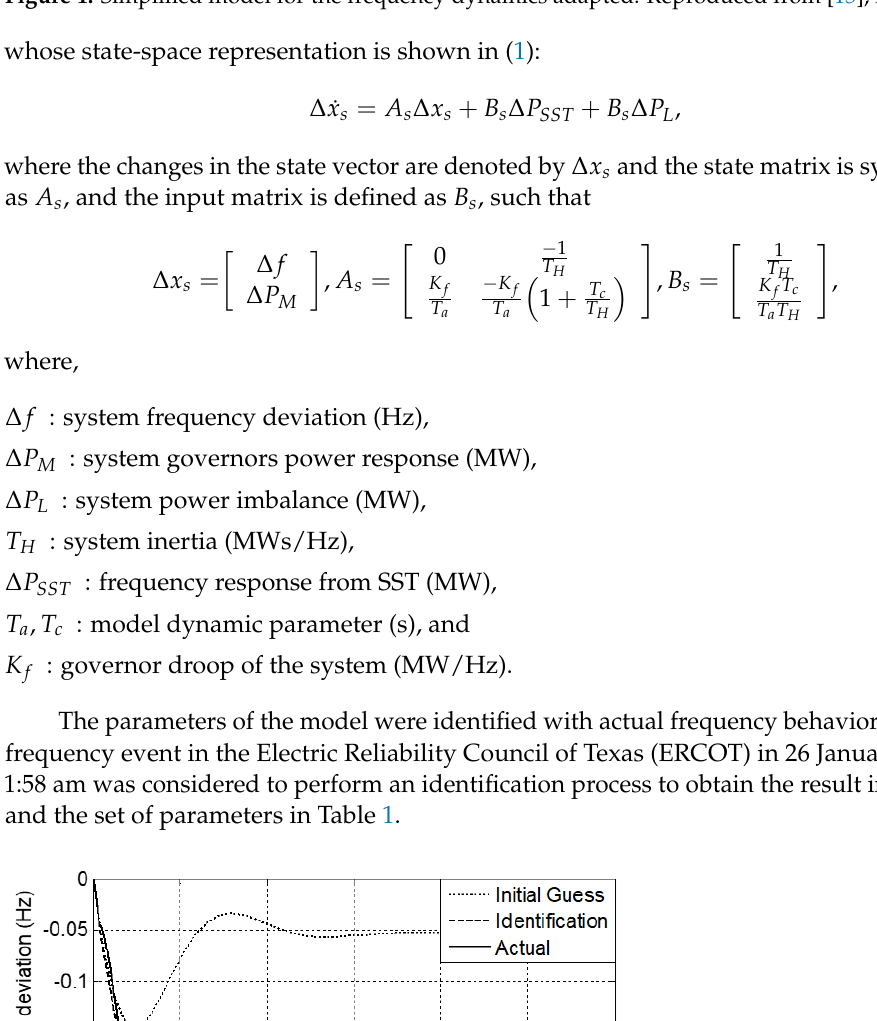
Figure 1. Simplified model for the frequency dynamics adapted. Reproduced from [15], IEEE: 2012.